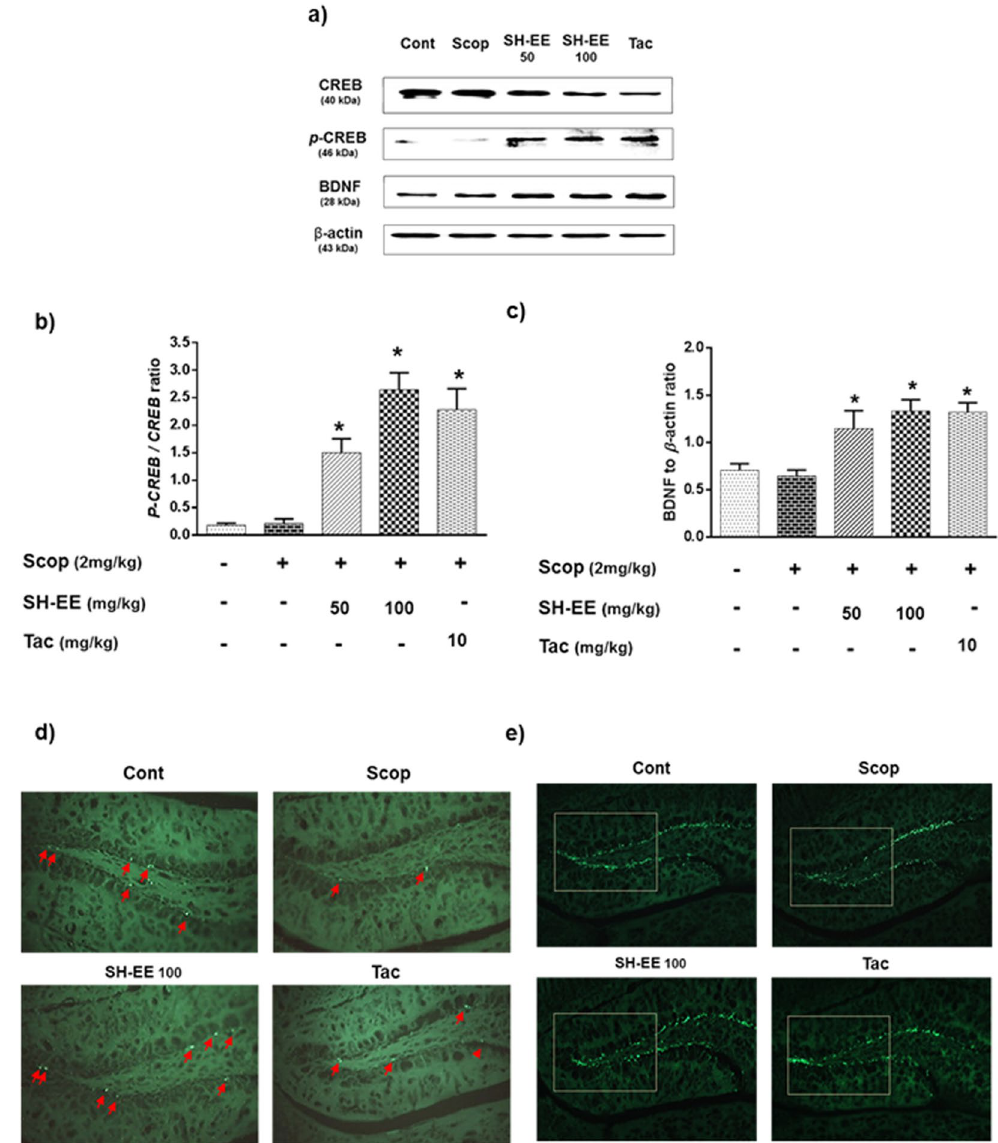
Figure 7. Effects of SE-EE on CREB/BDNF signaling and associated neuronal proliferation and neurogenesis in C57/BL6N mice: ( a ) CREB, p -CREB and BDNF protein expressions in the hippocampus (n = 3) were determined via western blotting (respective markers were acquired by cropping from different gels of parallel blotting, full length blots are in Supplementary data- S.3.3) and ( b , c ) represent the quantification of protein expression relative to β -actin or phosphorylated proteins using the ImageJ software. The data are expressed as mean ± SD. # p < 0.05 compared with the control group; * p < 0.05 other treated groups compared with the scopolamine group; Immunohistochemical analysis of hippocampal-DG regions (n = 3), ( d ) Ki67-positive stained progenitor cell were marked with red arrows in the subgranular zone of DG. ( e ) The DCX-positive stained immature neurons were observed as green flares in the subgranular zone of DG. Representative photomicrographs were taken at magnifications of